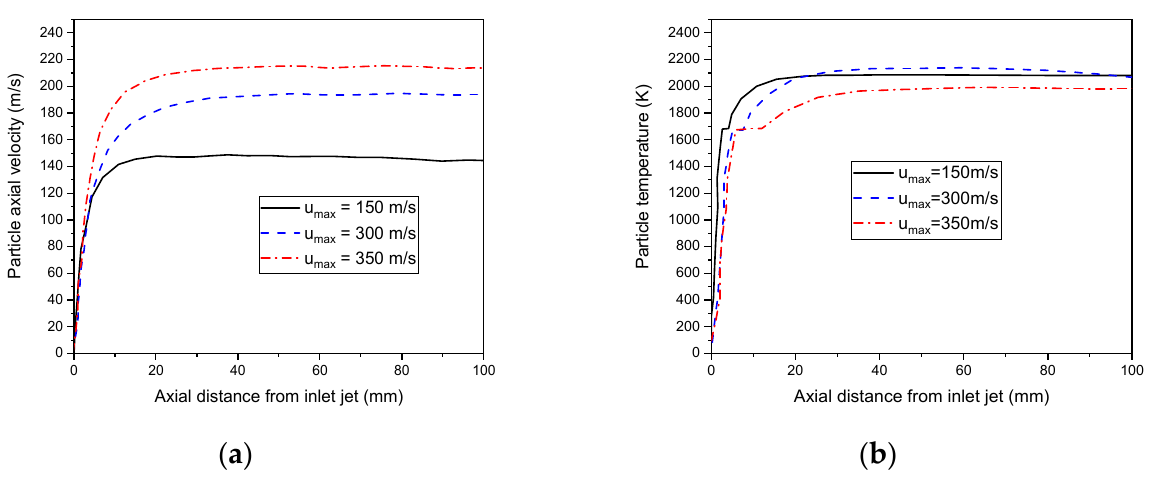
velocity on the particle’s velocity is shown in Figure 16a. For high gas velocities, particles gaining high speed increases are attracted to the central axis, owing to their lower pressures. velocity on the particle’s temperature. Indeed, particles reach the melting point (1685 K) with different residence times in the plasma jet. A high-velocity jet confines particles in the core flame and minimize their residence. Herein, particles own an elevated heat transfer coefficient, which consequently improves the thermal efficiency between the flame and the particle surface.